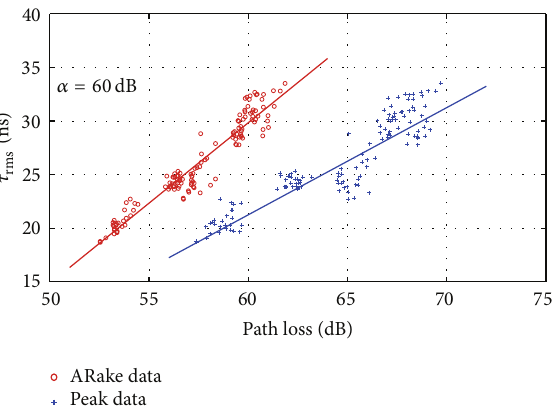
Figure 7: Scatter plot of rms delay spread versus path loss. The solid line corresponds to the linear